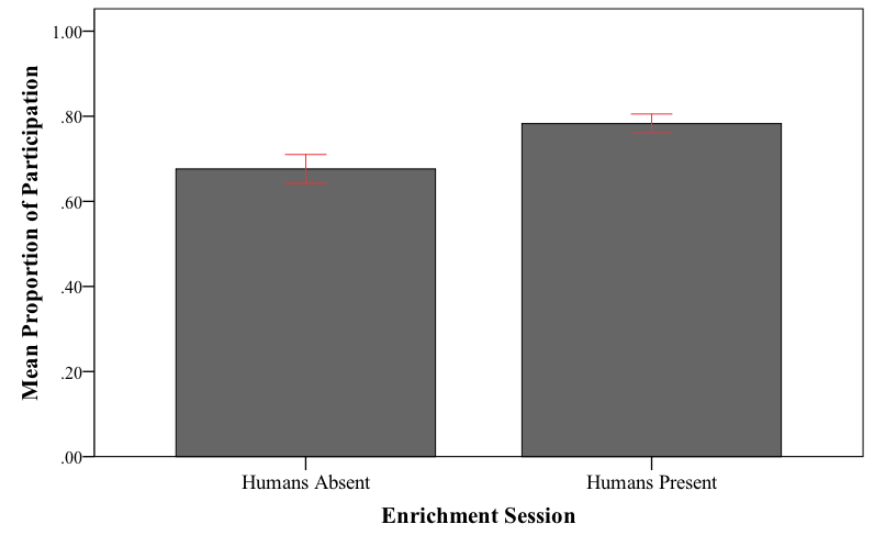
Figure 2 . Mean (±2 SE) proportion of subjects ( n = 19) that participated with human involvement enrichment classes versus non- human involvement classes, including all trials and subjects ( p < 0.05).